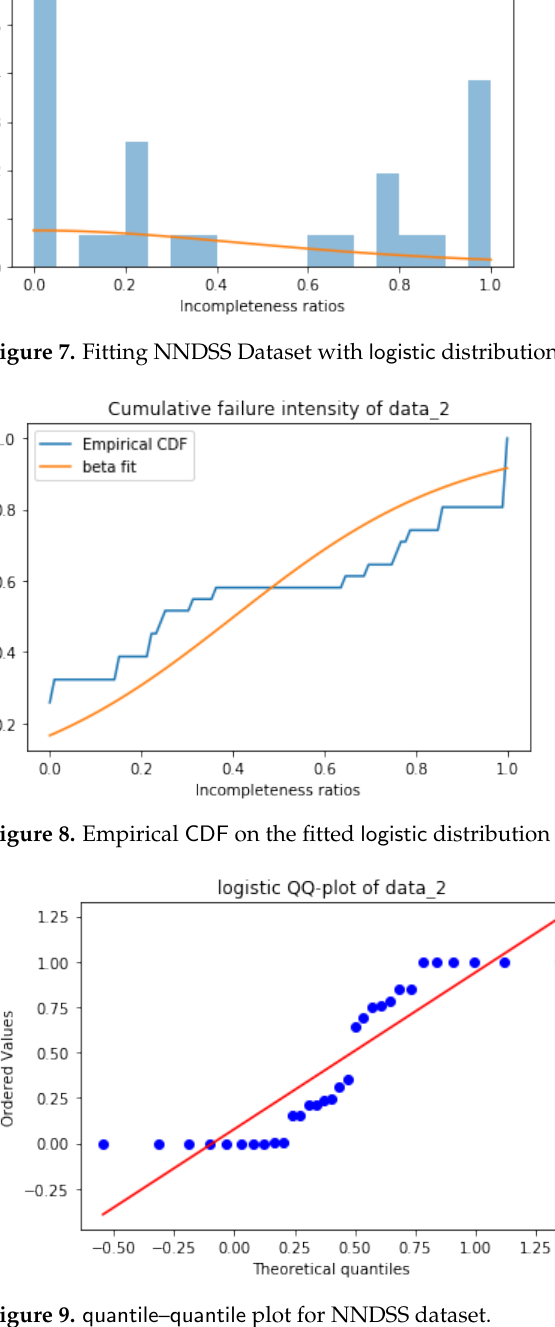
Figure 9. quantile – quantile plot for NNDSS